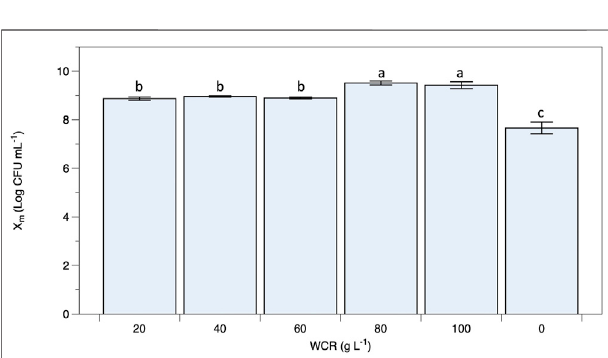
FIGURE 3 | Maximal B. coagulans ATCC 7050 growth using waste Arthrospira cell residues at various concentrations. All values are represented as mean